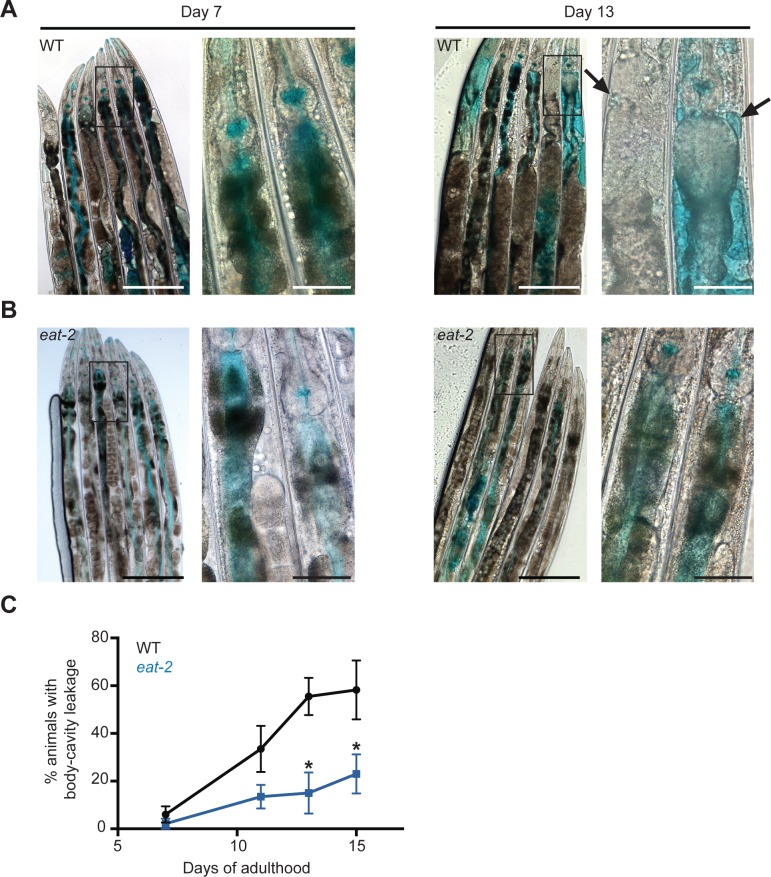
The age-related breakdown of intestinal barrier function is reduced in dietary-restricted eat-2 mutants.(A, B) DIC images of wild-type (WT, N2) animals (A) or eat-2(ad1116) animals (B) after soaking in blue food dye for 3 h on Day 7 (left) and Day 13 (right) of adulthood. Black arrows point to areas where blue dye has leaked from the intestinal lumen into the body cavity, giving rise to the Smurf phenotype. Scale bars, 200 μm (left panels) and 50 μm (right panels, showing higher magnifications of the boxed regions in the left panels). (C) Quantification of body-cavity leakage in WT and eat-2(ad1116) animals over time. Animals were examined after soaking in dye for 3 h on the indicated days of adulthood (see Methods). Data are the mean ± SEM of three biological repeats per time point, each with 8–10 animals. *P<0.03, Student’s t-test.